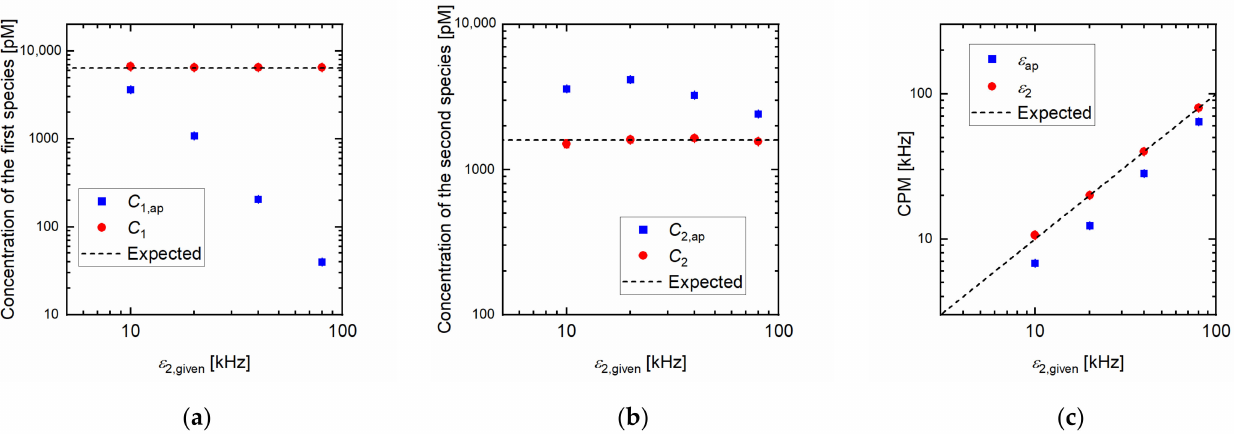
Figure 2. Dependency of the given CPM of the second species ε 2,given . ( a ) Dependency on the measured concentration of the first species C 1 ; ( b ) dependency on the measured concentration of the second species C 2 ; ( c ) dependency on the measured CPM. Error bars show the standard errors ( n =